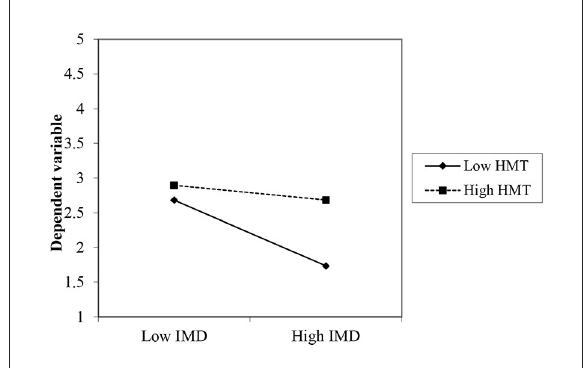
FIGURE3 Moderation of HMT between IMD and UWD (Slope